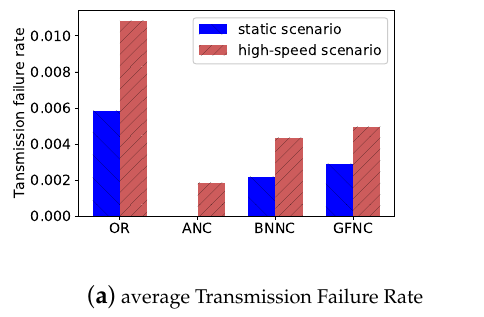
Figure 11. The average transmission failure rates and the throughput variances of different network coding schemes in real experiments. ( a ) the comparison of average transmission failure rates of each network coding scheme in the high-speed scenario and static scenario; and, ( b ) the variances of the combined data set of throughput in the high-speed scenario and static scenario, which reflect the fluctuation range of throughput for different network coding schemes when link quality